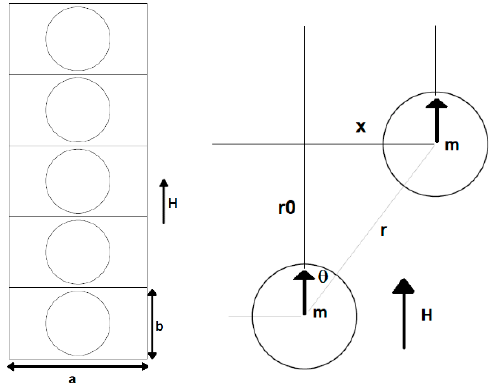
Figure 1. Particle column of an anisotropic magneto-rheological elastomer (MRE).